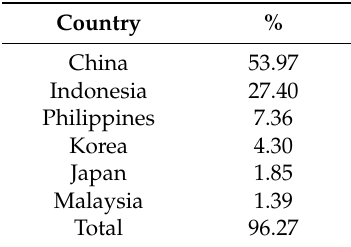
Table 1. Percentage of global farmed algae production.